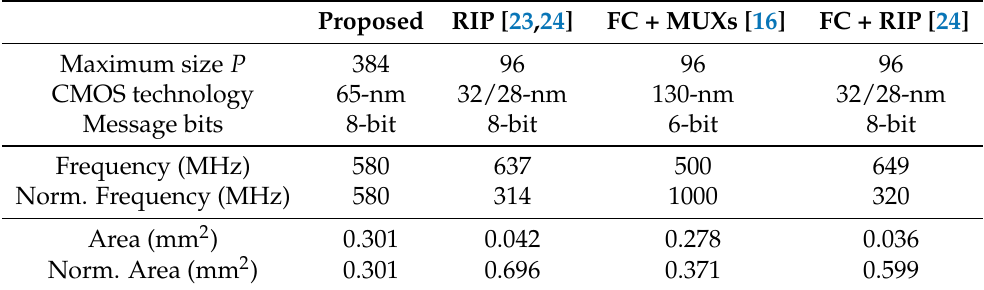
Table 2. ASIC Implementation Results of Multi-Size Circular-Shift Network for 5G NR LDPC Decoders. Proposed RIP [23,24] FC + MUXs [16] FC + RIP